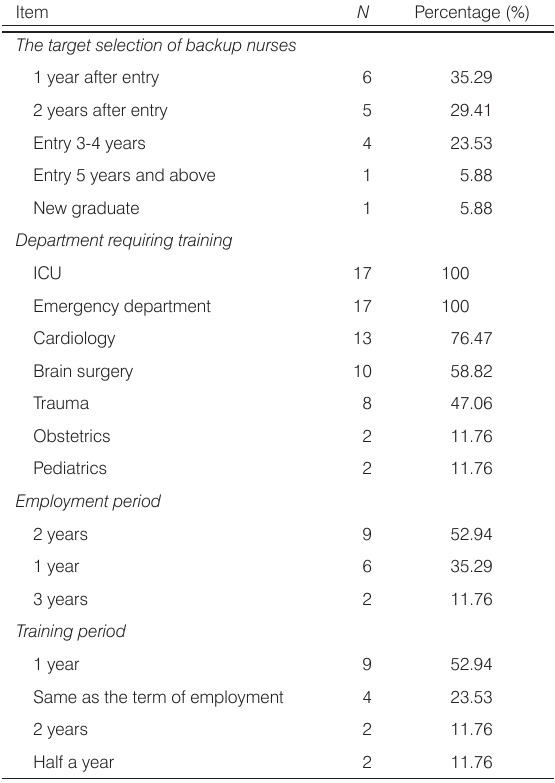
Table 1. The scope of backup nurse